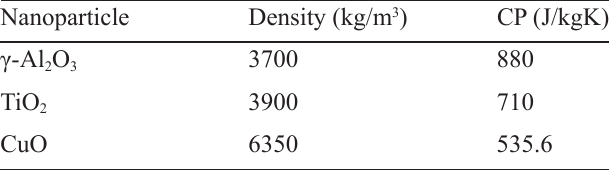
Table 1. Physical properties of the nanoparticles